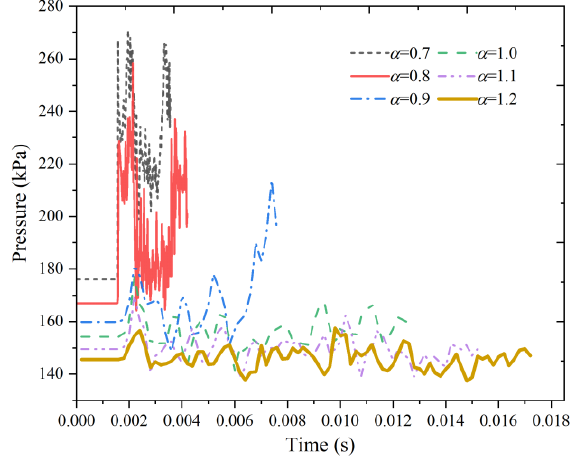
Figure 14. Results of the pressure measured at x= 0.7 m under different values of α.